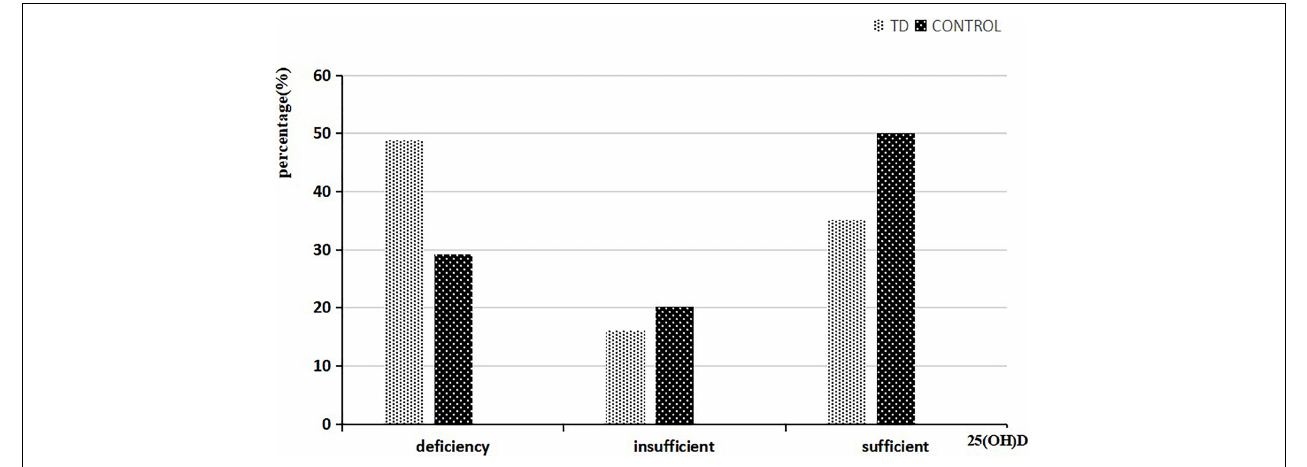
FIGURE 1 | Comparison of the different levels of 25-hydroxyvitamin D in the two groups.